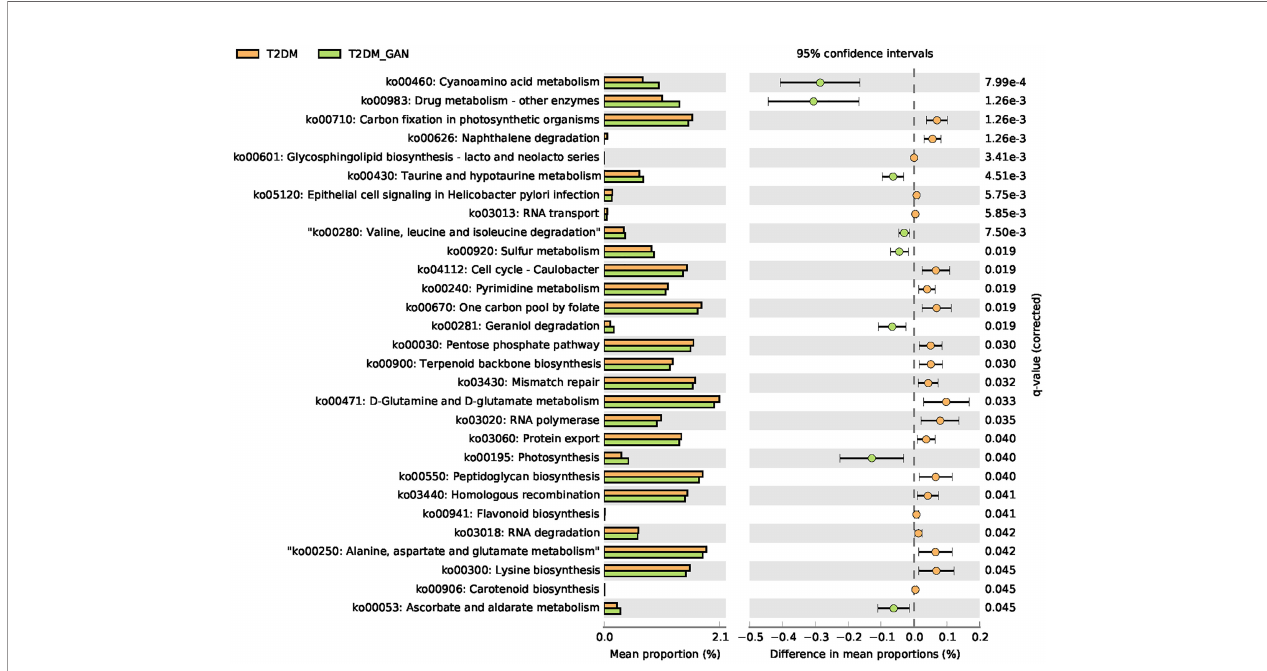
FIGURE 6 | The signi fi cantly and differentially pathway between T2DM and T2DM_GAN patients. The left X-axis represents different groups, the Y-axis represents the average relative abundance of a species in different groups, and the right represents the con fi dence interval and p